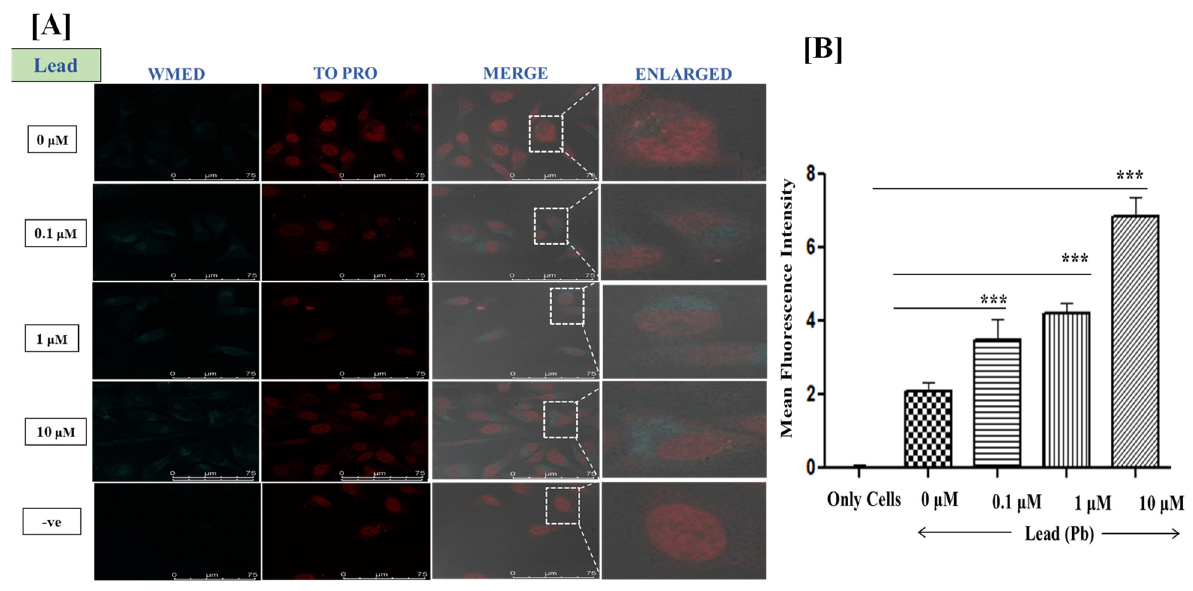
Figure 8. ( A ) Confocal fluorescence microscopy images at 100× Magnification; Live HeLa cells were incubated with Lead ions at 0.1 µM, 1 µM, and 10 µM concentrations for 1.5 h. Staining of Live HeLa cells with 0.128 mg/mL WMED, images recorded for WMED at λ ex 405 nm/ λ em 450–550 nm. The Nucleus is stained with TO-PRO nuclear dye λ ex 641 nm/ λ em 661 nm; ( B ) quantification of lead ions using ImageJ software version 1.46r, *** p < 0.001.